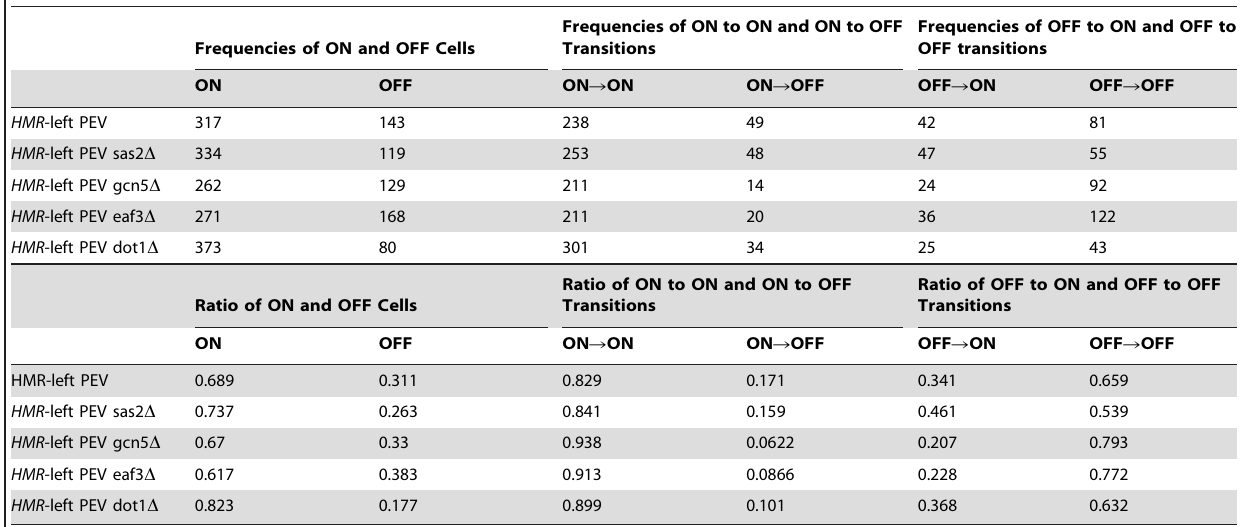
Table 3. Statistical test for state-transition with histone modification mutants.